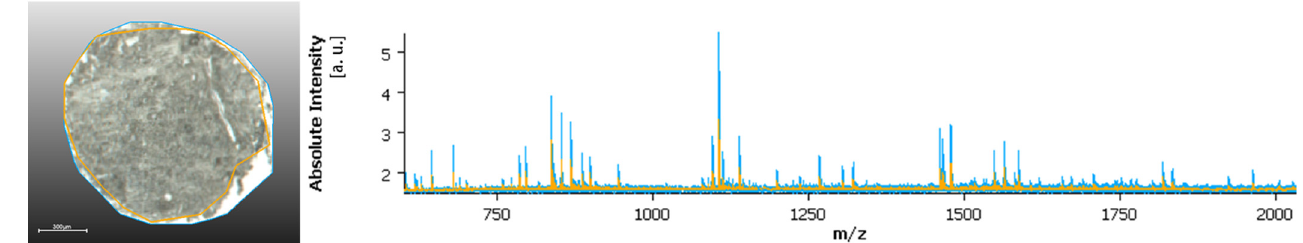
Figure 2. Spectral comparison: Mass spectrum of the whole measurement region (blue) and after the removal of the border regions (orange).